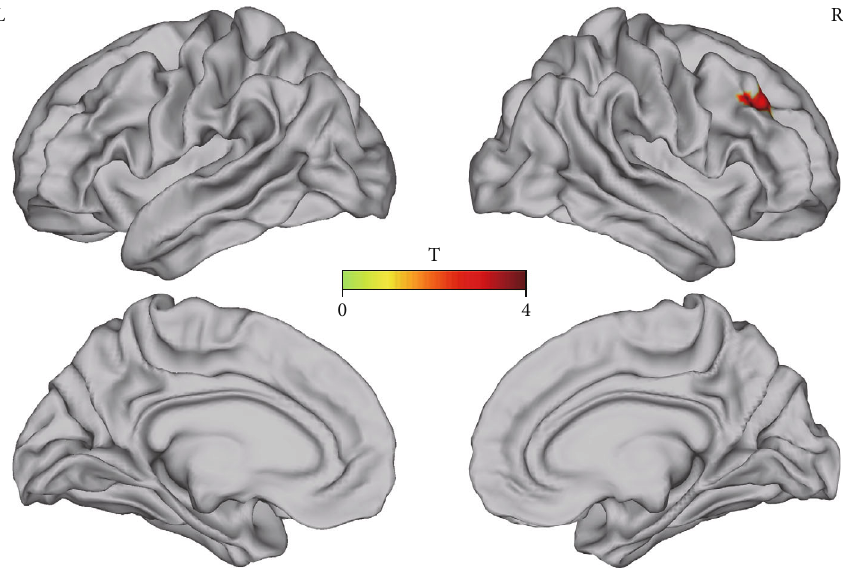
Figure 3: NFB-related ReHo changes. Increases in ReHo were primarily detected in the right frontal lobe. FWE correction: clusterwise threshold: p < 0 : 05 voxelwise threshold: p < 0 : 001